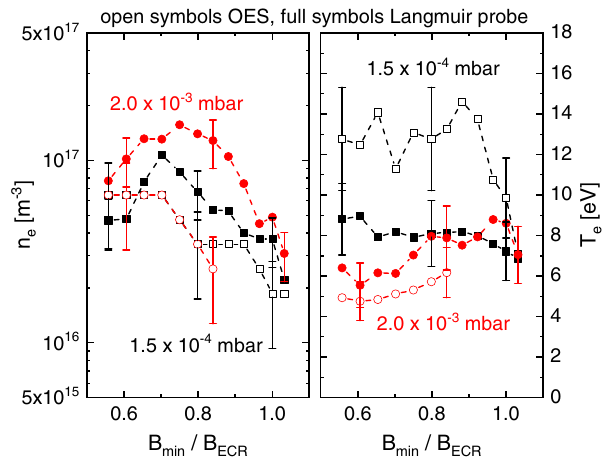
FIG. 8. Electron density and temperature calculated by means of LP and OES diagnostics versus B